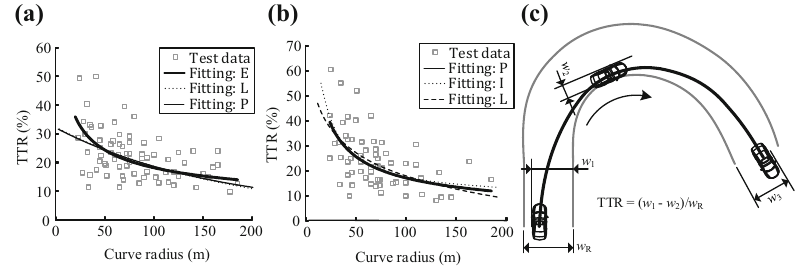
Fig. 10 ( a ) TTR with respect to curve radius for left bend; ( b ) TTR with respect to curve radius for right bend; ( c ) illustration